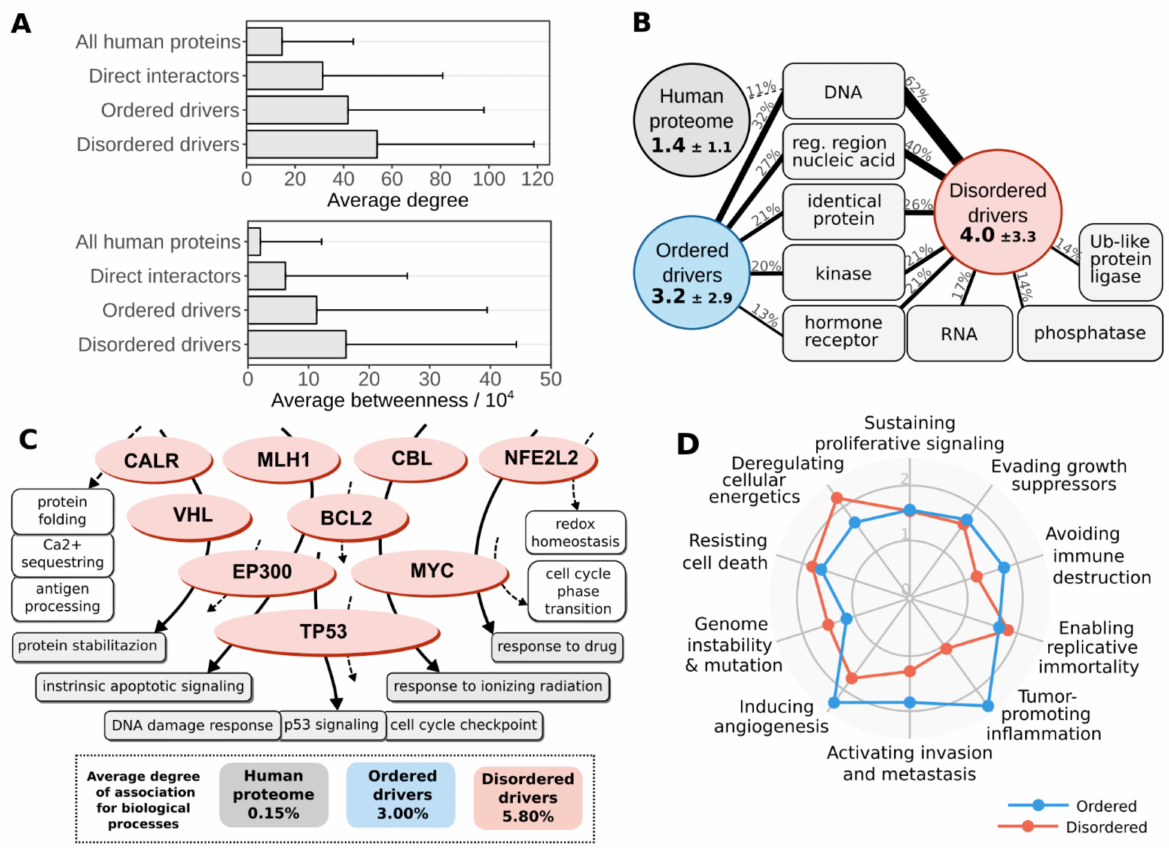
Figure 4. Characteristics of cancer drivers at the network/pathway and cellular levels. ( A ) Average degree (top) and betweenness (bottom) of all human proteins, showing the direct interaction partners of drivers, ordered drivers and disordered drivers. ( B ) The average occurrence of various types of interaction partners for the whole human proteome (grey circle), ordered drivers (blue circle) and disordered drivers (red circle). Values in circles show the average number of types of interactions together with standard deviations. The most common interaction types are shown in grey boxes, with connecting lines showing the fraction of proteins involved in that binding mode. Only interaction types present for at least 1/8th of the proteins are shown. ( C ) Top: An example subset of disordered drivers with associated biological processes marked with arrows (dashed and solid arrows marking processes involving only one or several disordered drivers). Bottom: Average values of overlap between protein sets of various biological processes, considering the full human proteome (grey), ordered drivers (blue) and disordered drivers (red). Process names in grey represent processes that involve at least two disordered drivers, names in white boxes mark other processes attached to disordered drivers. ( D ) Overrepresentation of hallmarks of cancer for ordered (blue) and disordered (red) drivers compared to all census